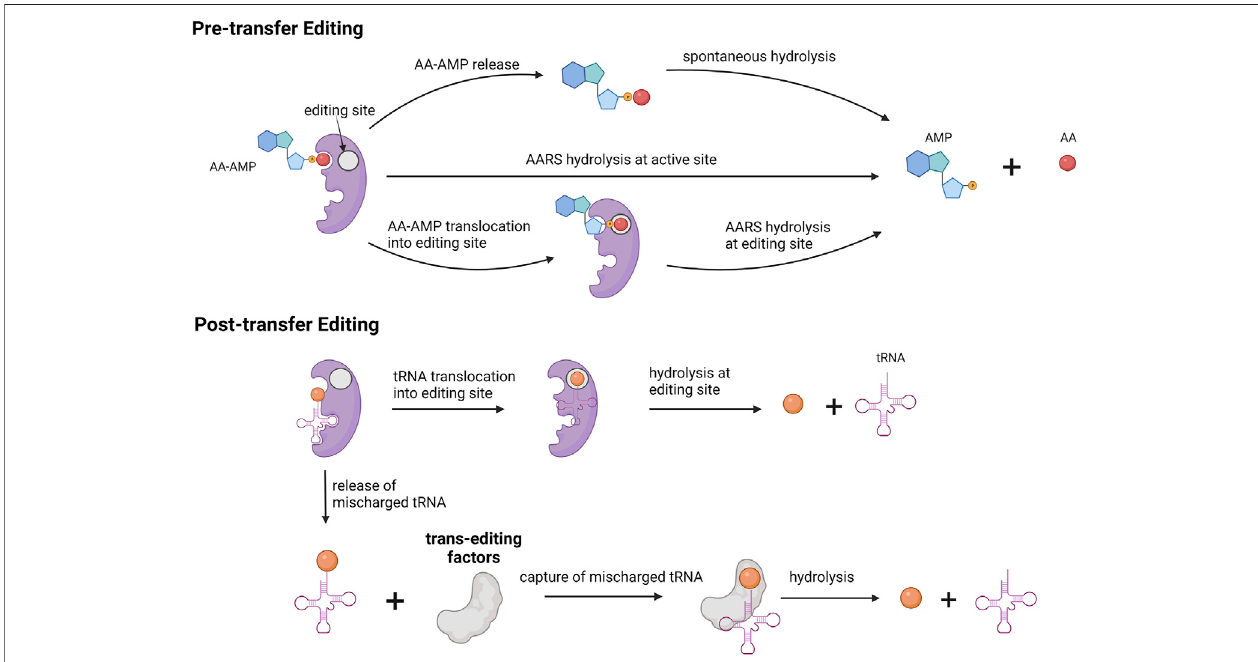
FIGURE 4 | Editing mechanism for aminoacylation process. Pre-transfer editing occurs before amino acid gets charged onto tRNA. Post-transfer editing occurs after amino acid is charged onto tRNA. Trans editing factors are independent editing proteins involved in hydrolysis of mischarged tRNA.